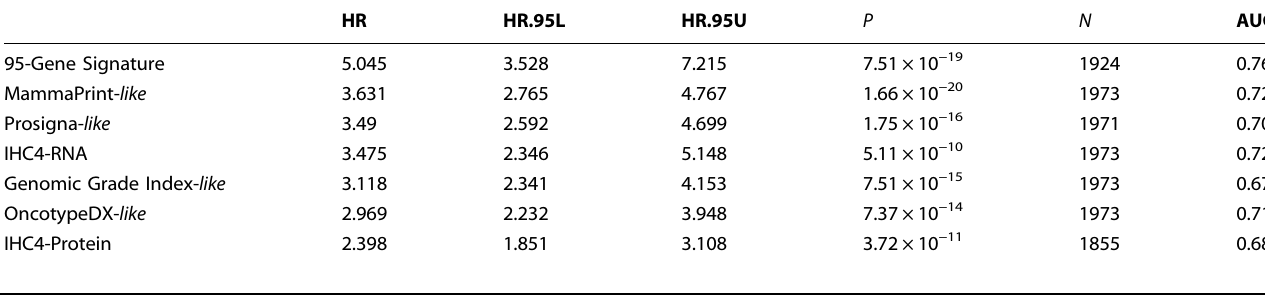
Table 2 Performance of the 95-gene residual risk signature and multiparametric tests in the validation cohort